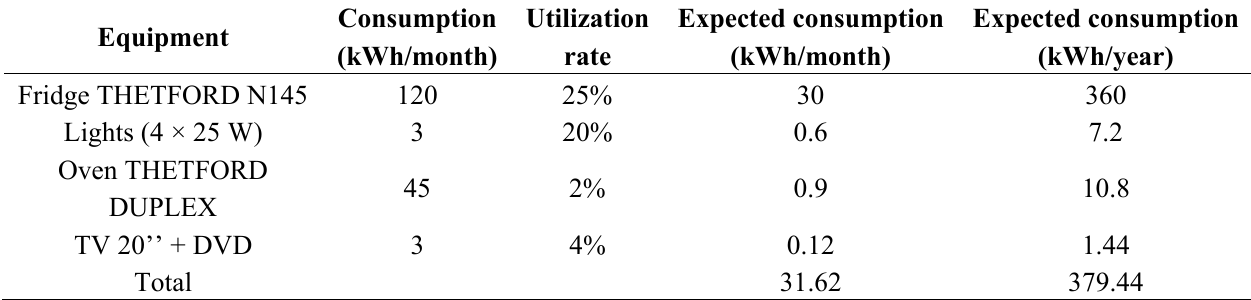
Table 4. Expected electricity consumption during the simulation